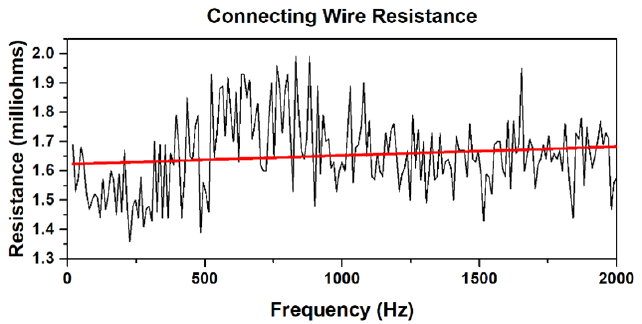
Figure 6. Actual experimental setup showing the power analyser, the motorette and the data logger for reading temperature inside the slot.